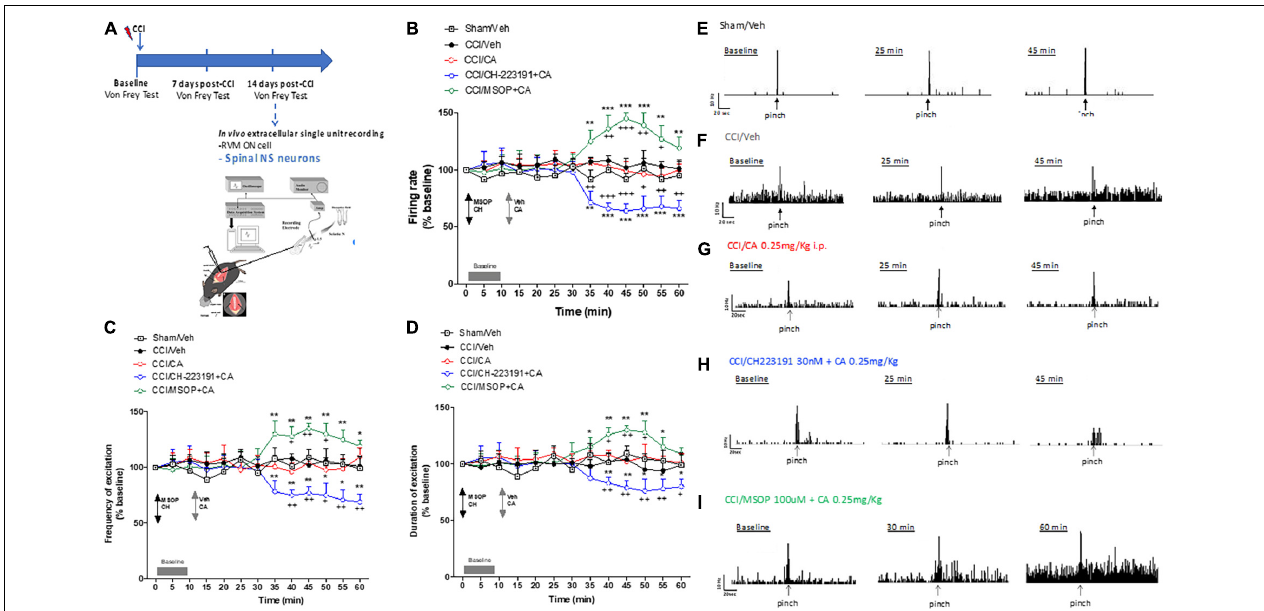
FIGURE 4 | Spinal cord neuronal hyperexcitability is oppositely modulated by mGlu4 or aryl hydrocarbon receptor in WT CCI mice. (A) Experimental timeline (top) and graphical representation of extracellular recordings of spinal NS neurons in anesthetized mice. (B–D) Mean ± S.E.M population data of spinal cord application of MSOP (100 uM) or CH223191 (30 nM) in presence of single systemic injection of cinnabarinic acid (CA, 0.25 mg/Kg) on firing rate (B) , frequency (C) , and duration of excitation (D) of NS neurons, in CCI mice. Black arrows indicate MSOP or CH223191 spinal application. Grey arrows indicate vehicle or CA spinal application. Grey bars indicate interval recordings of basal neuronal activity. Each point represents the mean of five different mice per group (one neuron recorded per each mouse). * p < 0.05, ** p < 0.01, and *** p < 0.001 indicate statistically significant difference vs. baseline, + p < 0.05, ++ p < 0.01, and +++ p < 0.001 indicate statistically significant difference vs. CCI/CA. Two-way ANOVA for repeated measures followed by Tukey’s post-hoc test was used for comparison between groups. Two-way ANOVA for repeated measures followed by Sidak post-hoc test was used for comparison between pre-drug and post-drug values. (E–I) Representative ratemeters showing spontaneous and noxious-evoked activity of NS neurons in Sham mice (E) or in CCI mice before and after treatment with vehicle (F) , CA (0.25 mg/Kg) (G) , CH223191+CA (H) , and MSOP+CA (I)